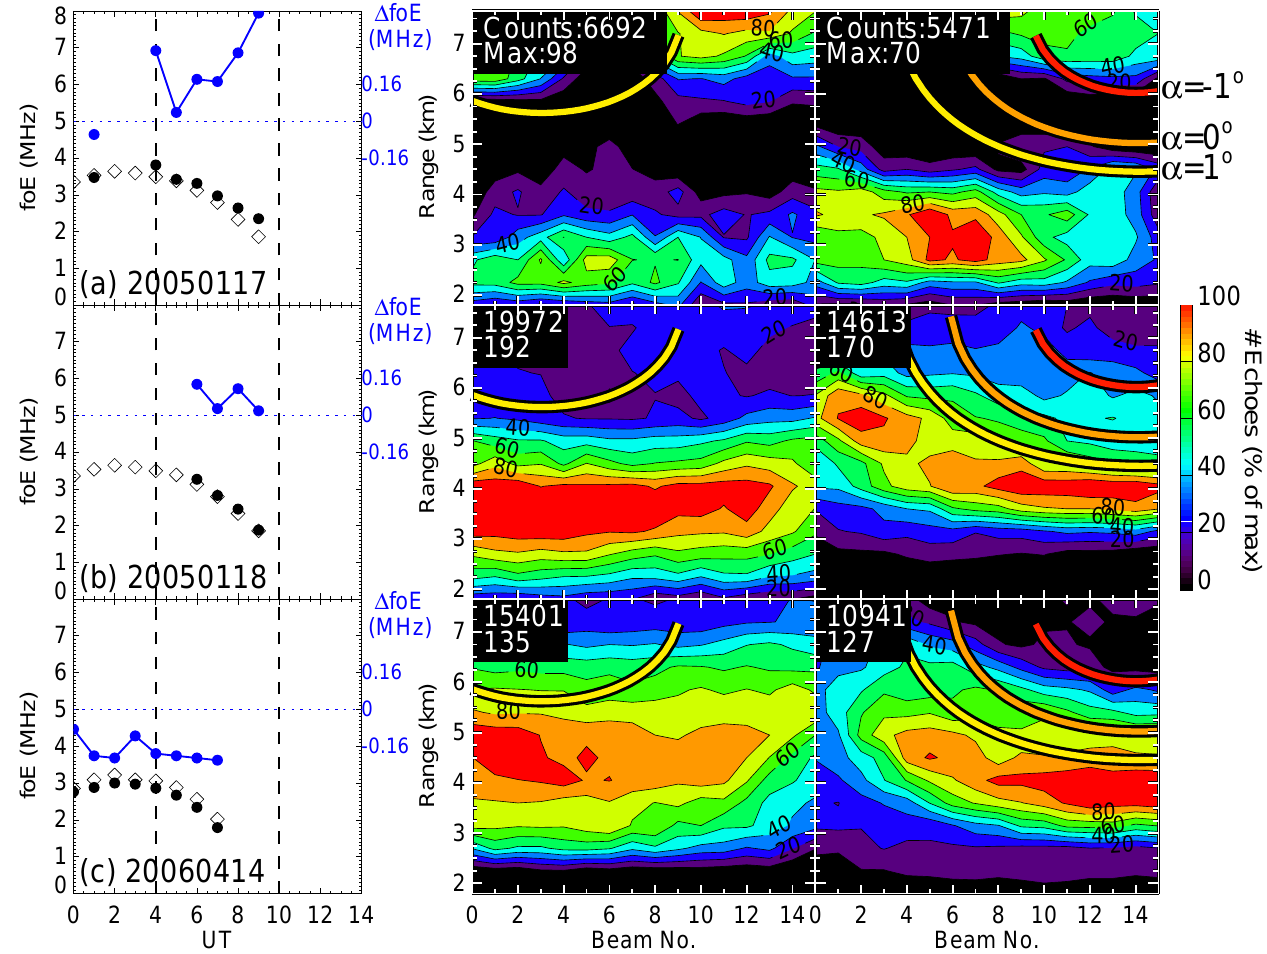
Fig. 8. Examples of the Hobart ionosonde measurements (left column) and spatial occurrence plots for the Bruny Island (center column) and the Unwin (right column) radars for the three selected storm events: (a) 17 January 2005, (b) 18 January 2005, and (c) 14 April 2006. The variation of the storm-time hourly median E layer critical frequency f 0 E (black circles) is shown along with the quiet time variation (diamonds). The difference between the measured storm-time critical frequency and that measured during quiet time ( 1f 0 E ) is also plotted as blue circles. The scale for 1f 0 E is shown on the right. The interval of interest 04:00–10:00UT is shown by the dashed lines. The plots in the center and right columns are in the same format as Fig.